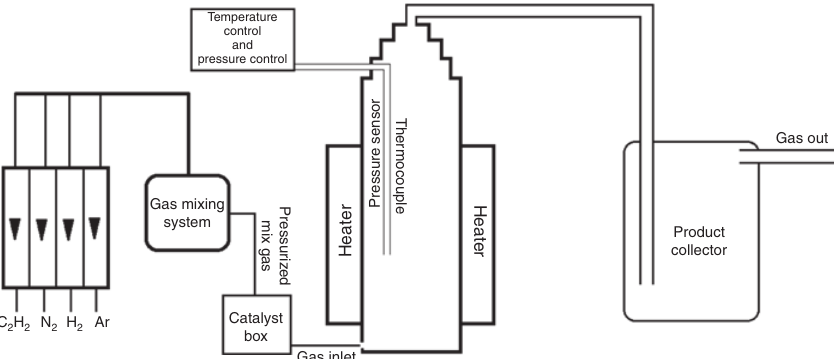
Figure 1 Schematic representation of fluidized bed reactor